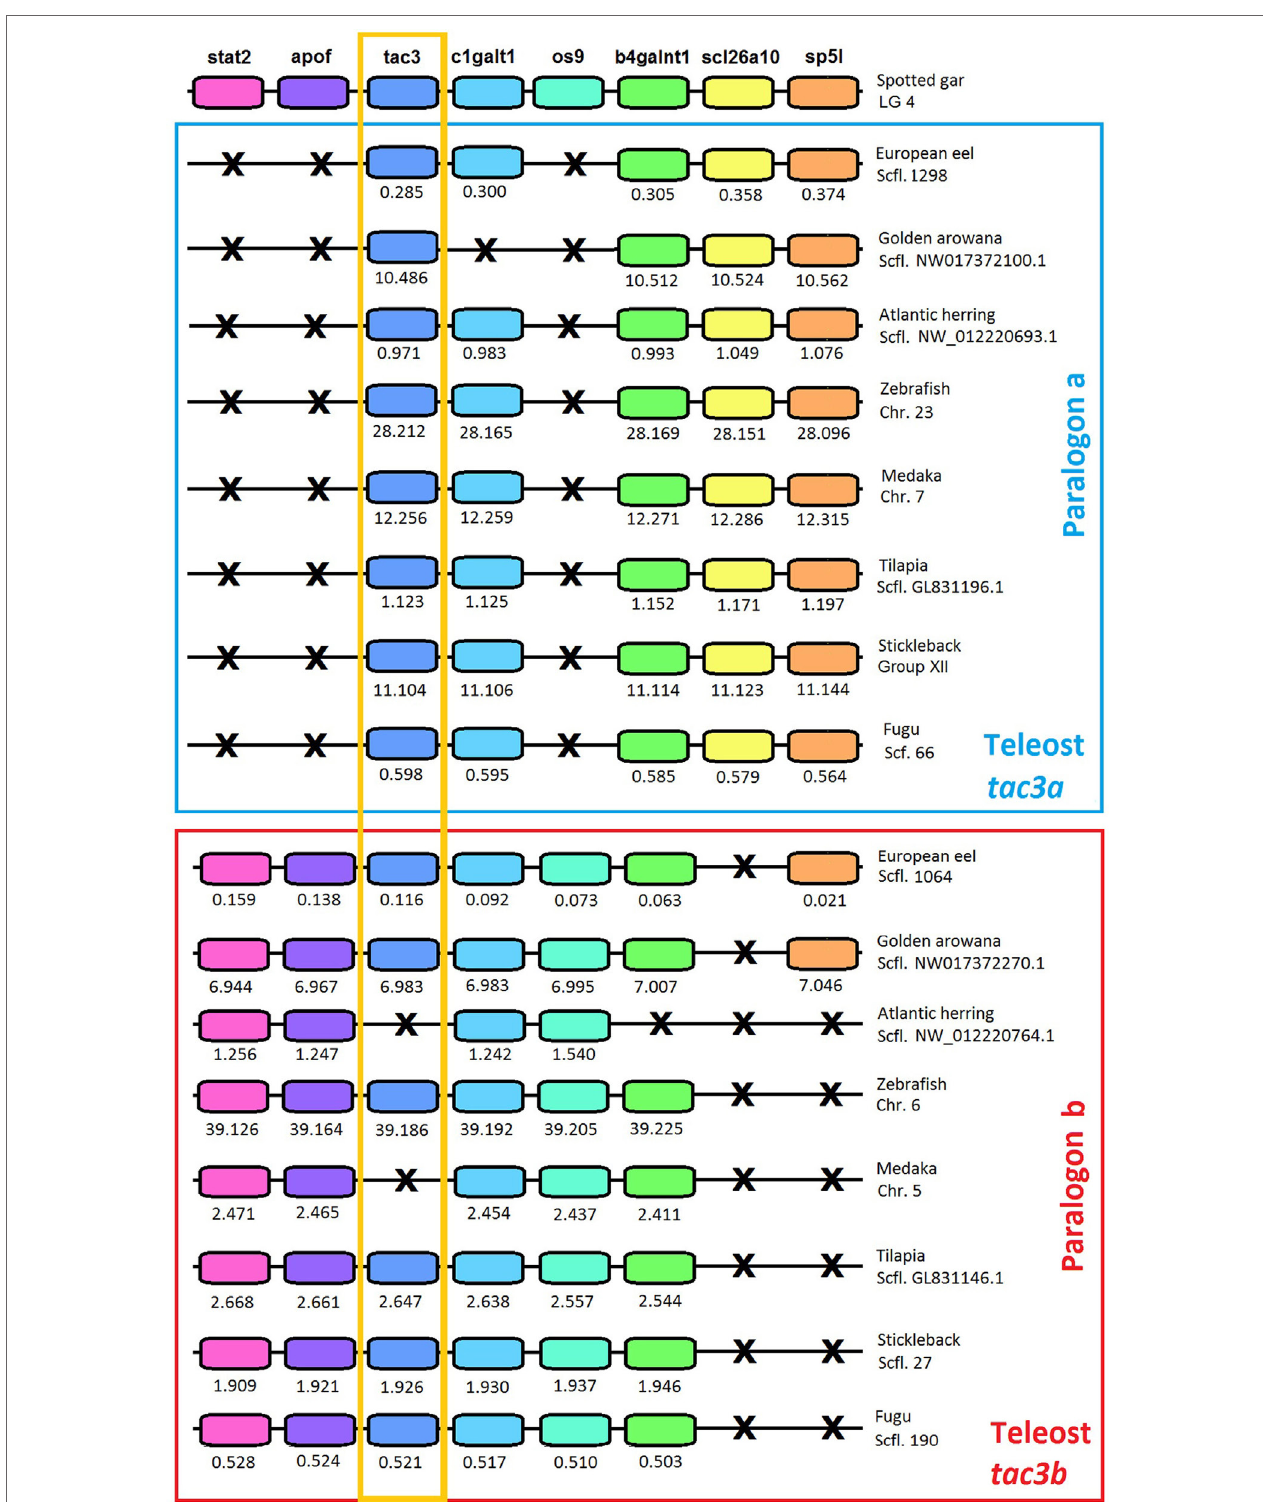
FigUre 3 | Syntenic region of tac3 in key teleost species and the actinopterygian spotted gar. Spotted gar tac3 genomic region is used as a reference. This region is duplicated in teleosts. Blue square includes teleost paralogon a, and red square includes teleost paralogon b. Gene color is preserved for homologous genes. The tac3 genes are highlighted by an orange square. Gene losses are marked with a cross. For each species, chromosome or scaffold is indicated. Below each gene, its position is indicated in 10 6 bp. The full gene names, reference, and detailed genomic locations are given in Table S3 in Supplementary Material.